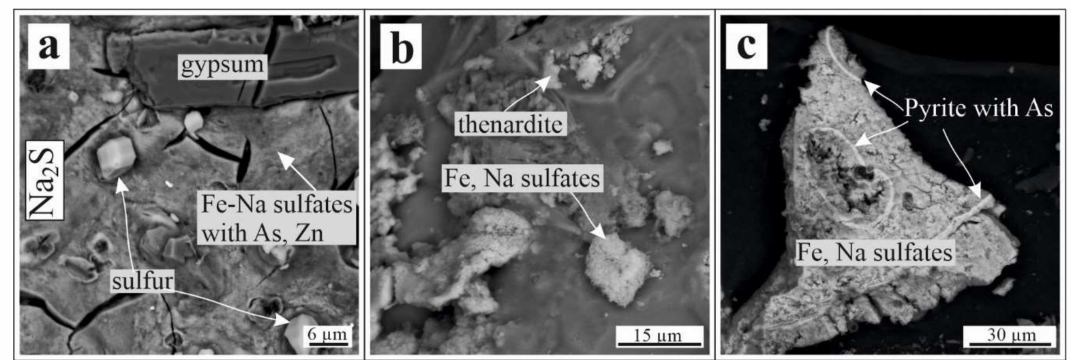
Figure 7. Scanning electron microscopy images of the precipitates after the experiments with Na 2 S: ( a ) crystals of native sulfur in the mass of sulfates; ( b ) fine-grained intergrowths of sulfates; ( c ) veins and borders of pyrite in the mass of sulfates.